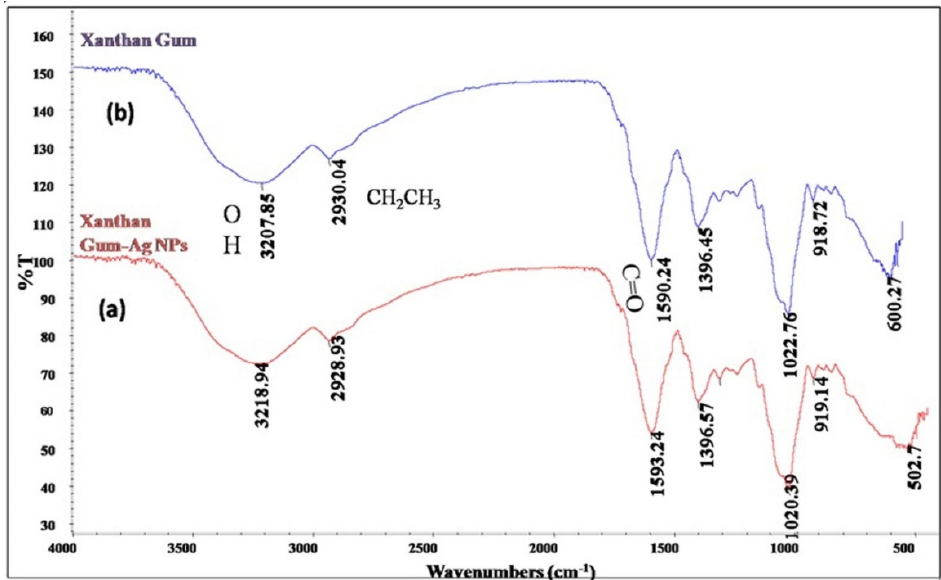
Figure 4. FTIR spectra of (a) XG-AgNPs and (b) Xanthan gum.